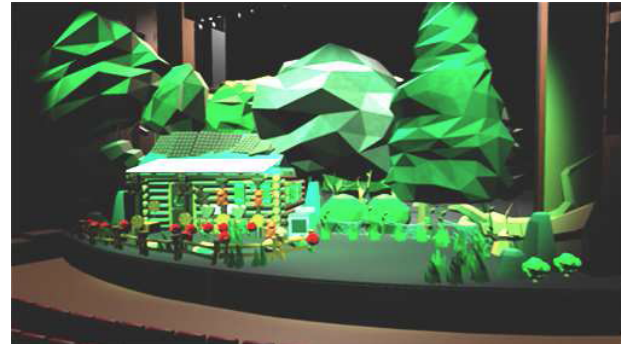
Figure 4. Witch house scene from the tale Hansel and Gretel created during the study